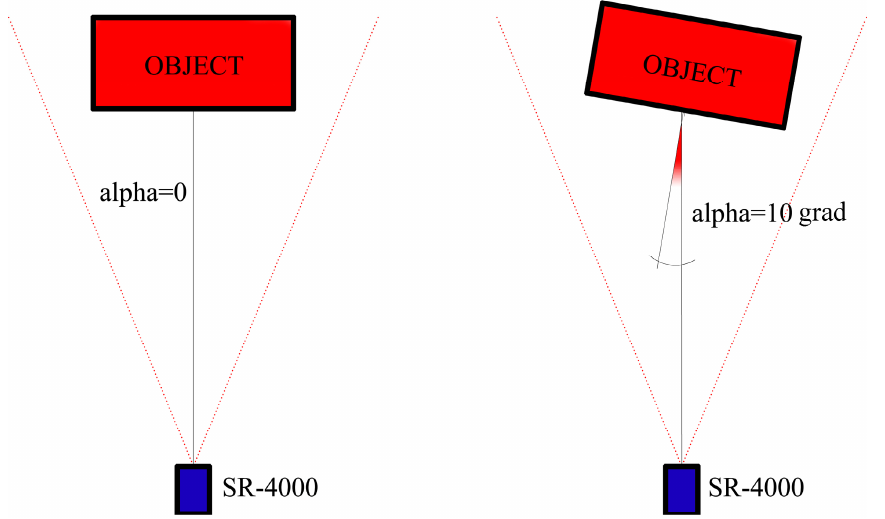
Figure 7. Alpha angle between camera optical axis and the normal to the object